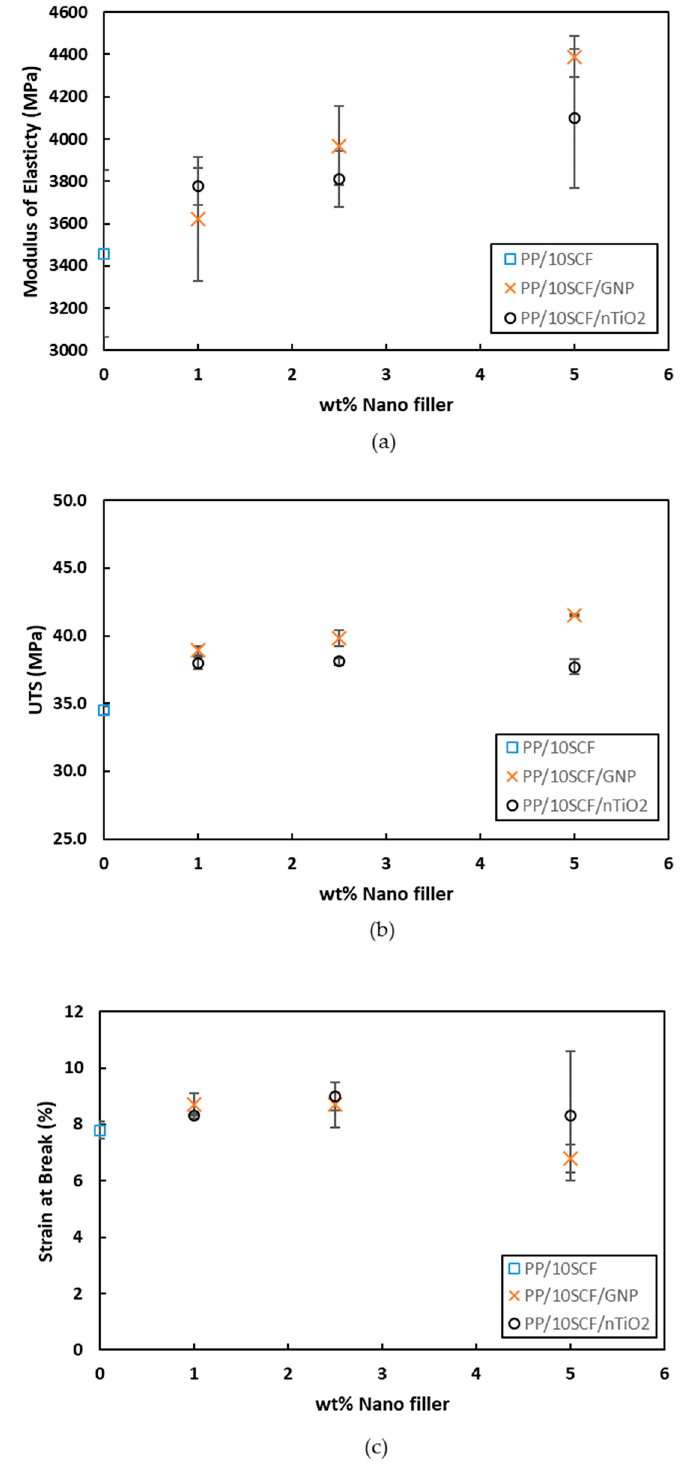
Figure 11. ( a ) Tensile modulus, ( b ) Ultimate tensile strength (UTS), and ( c ) Strain at break vs. wt % PP/10SCF/nanofiller.